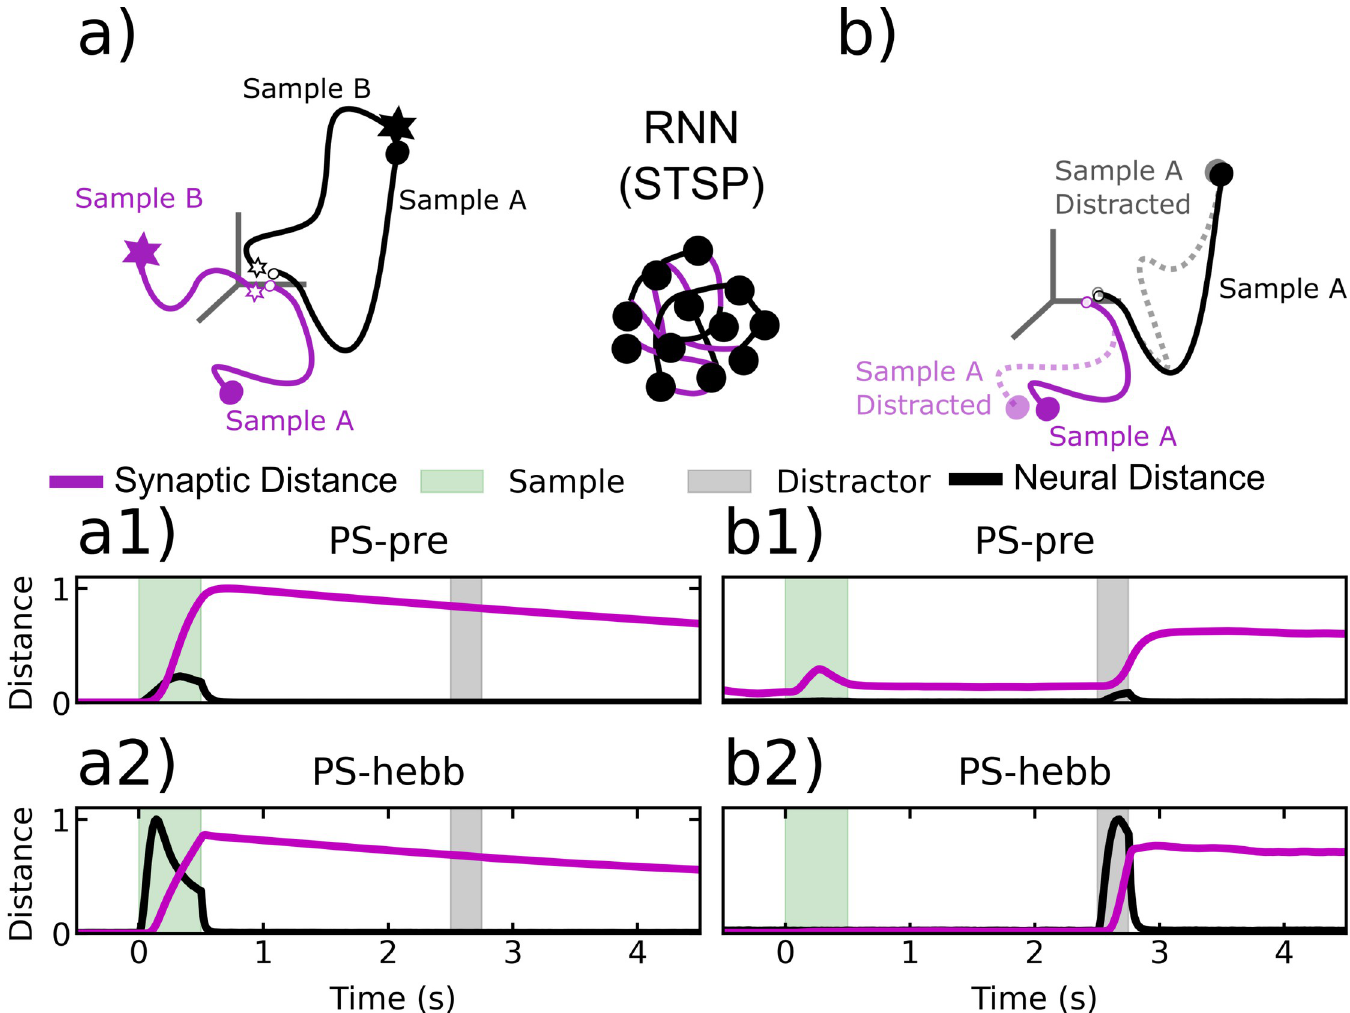
Fig 8. Distances between neural and synaptic trajectories within a sample condition and between sample conditions, for plastic synapse RNNs. Black lines correspond to neural trajectories, purple lines correspond to synaptic trajectories. a) Cartoon of trial-averaged neural and synaptic RNN trajectories corresponding to two different sample conditions for the plastic-synapse RNNs. a1) Average pairwise distance between neural and synaptic trajectories on different sample conditions, for PS- pre. a2) The same plot as in a1, but for PS-hebb. b1) The average distance between distracted and undistracted trajectories. Average taken over all sample conditions. Results shown for PS-pre. b2) Same results as in b1, but for